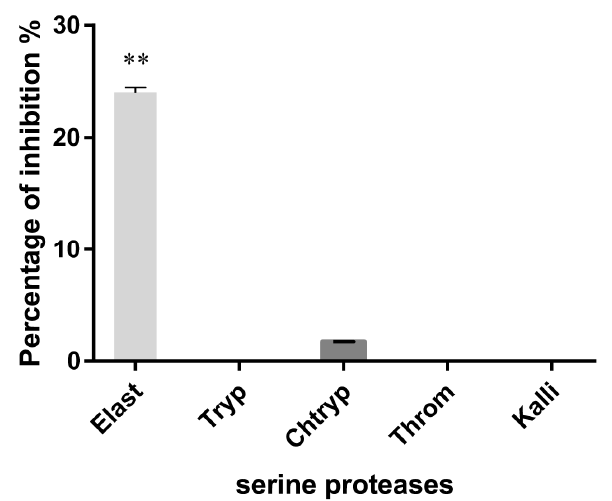
Figure 2. Inhibition of serine proteases by IrSPI. The ability of IrSPI (1µM of refolded protein in the refolding buffer) to inhibit the activity of elastase (Elast), trypsin (Tryp), chymotrypsin (Chtryp), thrombin (Throm), and kallikrein (Kalli) on synthetic substrates was evaluated at 37 °C for 30 min. Enzyme activity was evaluated from the slope of A 405 versus time and results were expressed as the mean of IrSPI-induced percentage inhibition after subtraction of the refolding buffer effect and comparison with the control. Double asterisks (**) indicate significant results as determined via ANCOVA analysis ( p < 0.001).